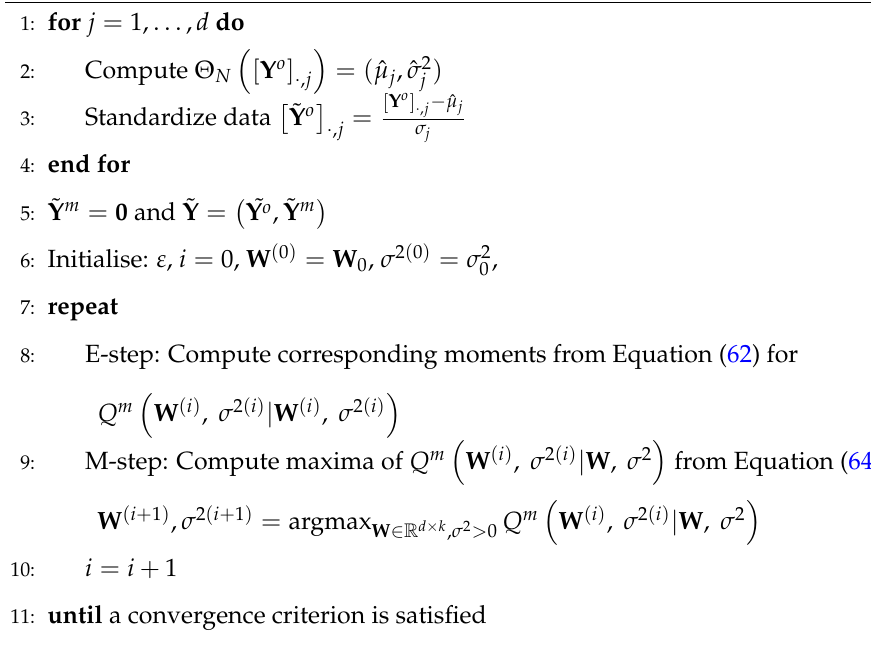
Algorithm 1 Probabilistic Principal Component Analysis with missing